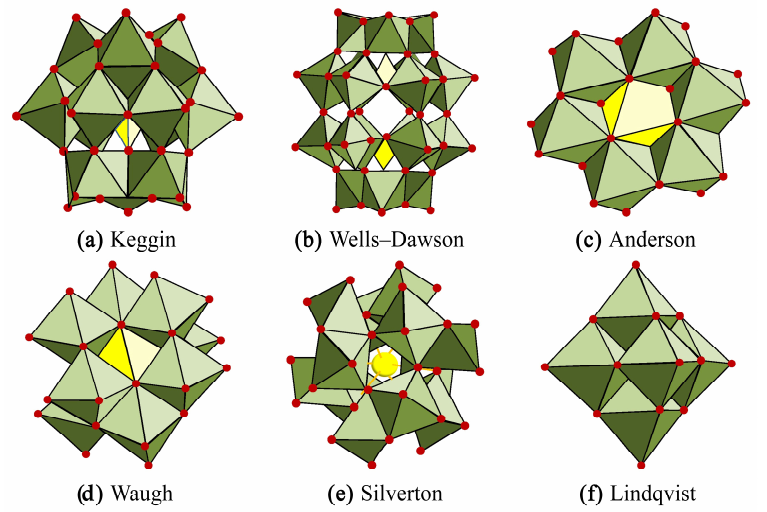
Figure 4. Polyhedral representation of conventional types of polioxometalates [118]. Copyright 2020, MDPI, adapted from Ref. [126], Copyright 2014,